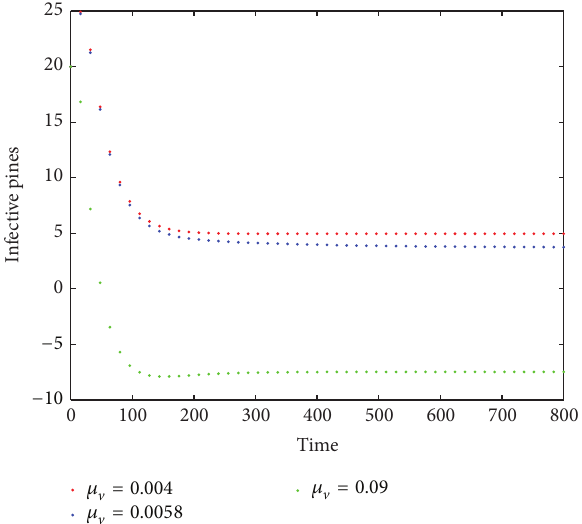
Figure 2: The effect of 𝜇 V on infected pine trees for Π ℎ = 0.22 , Π V = = 0.02 , 𝜔 = 0.03 , 𝜇 = 0.004, 0.0058, 0.09, 𝛽 0.32 , 𝜇 ℎ V = 0.00034 , 𝛿 = 0.0016 , 𝛿 = 0.00016 , 𝜃 = 0.00301 , 𝛼 𝛽 2 1 2 and 𝛼 2 = 0.001 .